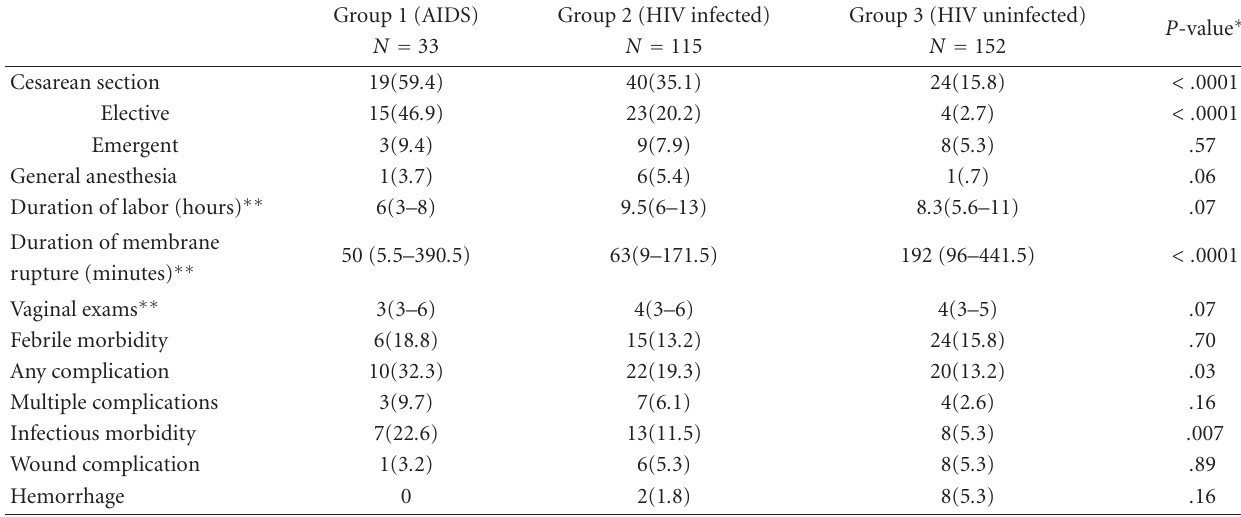
Table 2: Clinical data by group. †